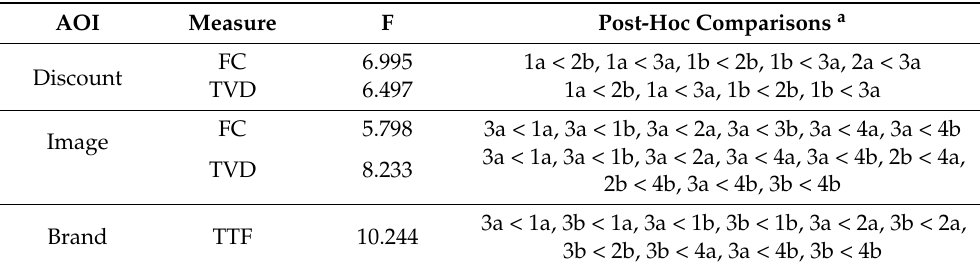
Table 2. Test results demonstrating the influence of the banner types on the visual attention. AOI Measure F Post-Hoc Comparisons a FC Discount